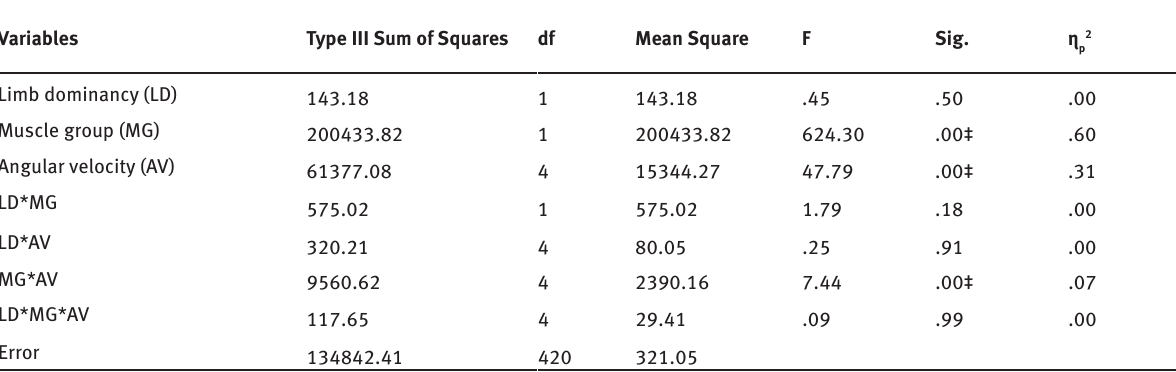
Table 2: Effect of the monitored independent variables on isokinetic strength (dependent variable).